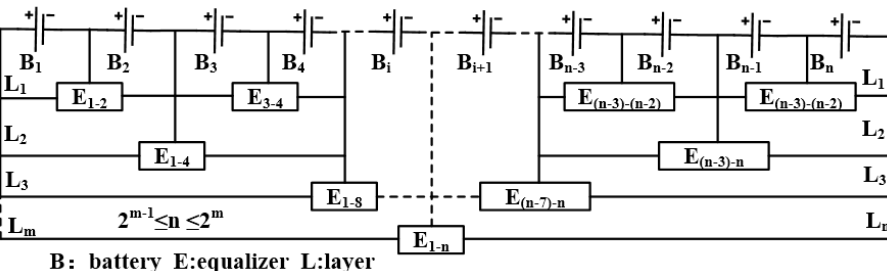
Figure 2. The parallel architecture equalizer proposed in [7].